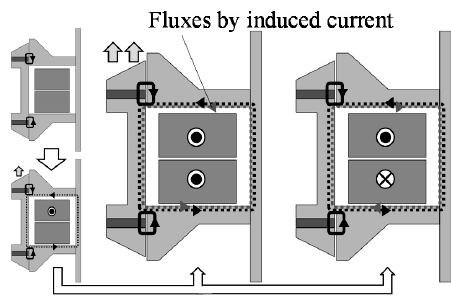
Figure 6. Operational principle in parallel.